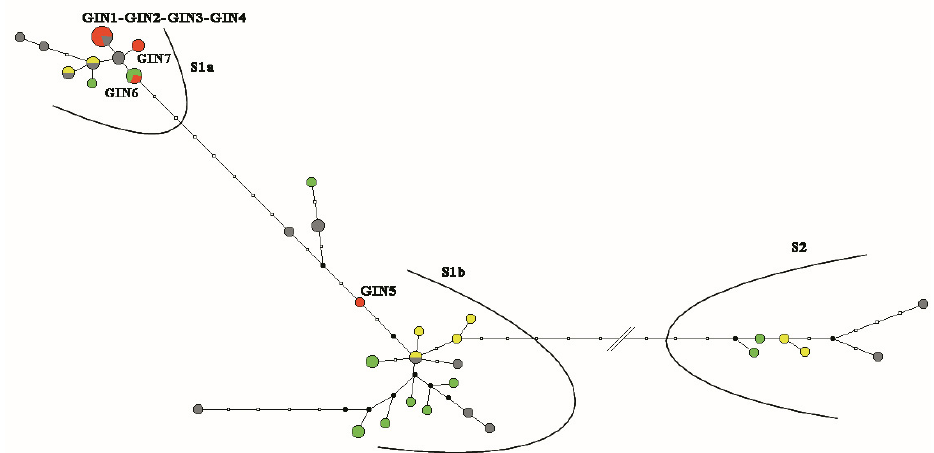
Figure 3. Multidimensional scaling plots of pairwise Fst values representing di ff erences in Helicobacter pylori genotype distribution between gastric intraepithelial neoplasia (GIN, red square), non-atrophic antral gastritis alone (NAG), NAG plus duodenal ulcer (NAG_DU) and NAG plus gastric erosions (NAG_GE) (black squares). A: combined vacA s and m sequences. B: vacA s sequences.